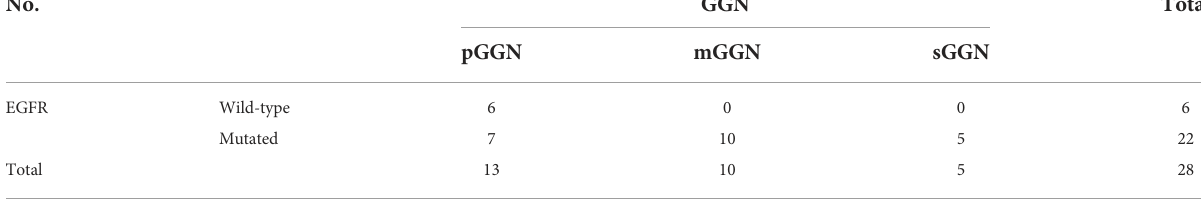
TABLE 3A Correlation of EGFR and type of GGN. No.